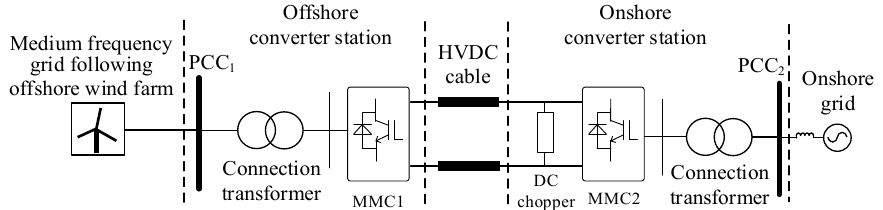
Figure 5. Scheme 4-HVDC transmission scheme for medium frequency grid-following offshore wind farms. wind